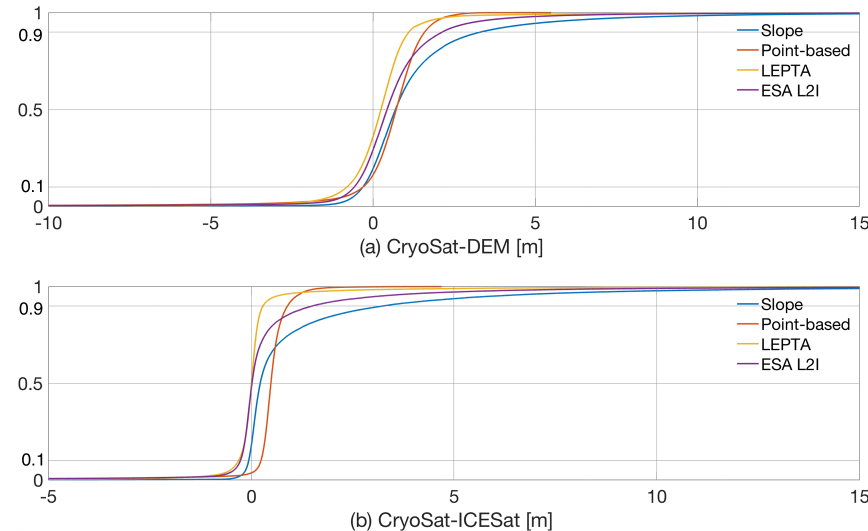
Figure 2. Cumulative distribution figures of (a) the difference between CryoSat-2 and ArcticDEM ( h C − h DEM ) and (b) the difference between CryoSat-2 and ICESat-2 ( (cid:49)h ), including outliers. The 10th and 90th percentiles are shown in the figures for outlier removal. For visualisation, the x axis is restricted to [ − 10, 15]m for (a) and to [ − 5, 15]m for (b) . Table 1. Statistics of the height difference between slope-corrected CryoSat-2 measurements and ArcticDEM and ICESat-2 ( h C − h DEMC or (cid:49)h as computed by Eq. 16). Height statistics are in unit of metres. The parameters are shown with and without outliers (referred to as w/ outlier and w/o outlier) using 10th and 90th percentiles. E, S, P and L represent ESA L2I, slope method, point-based method and LEPTA, respectively.